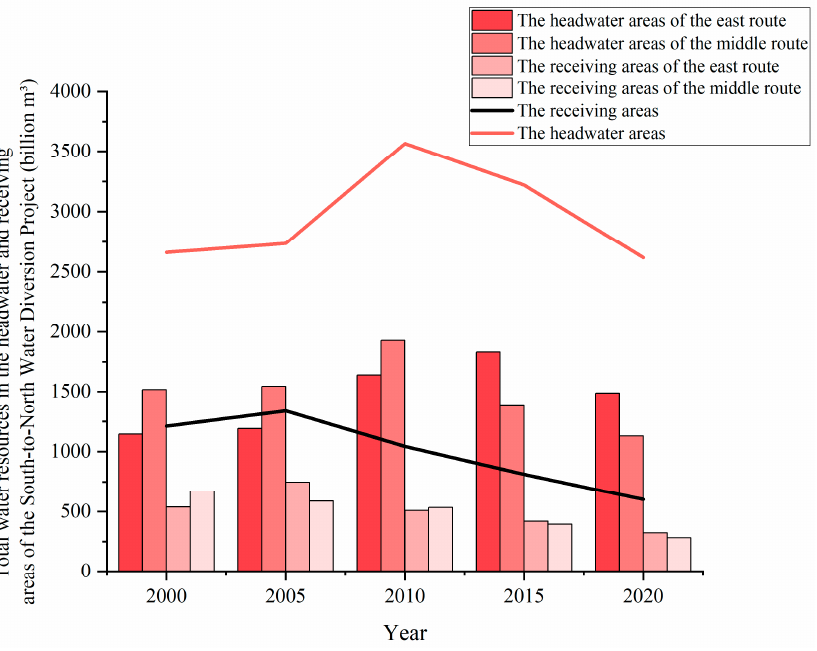
Figure 6. Total water resources of different subareas in five years.